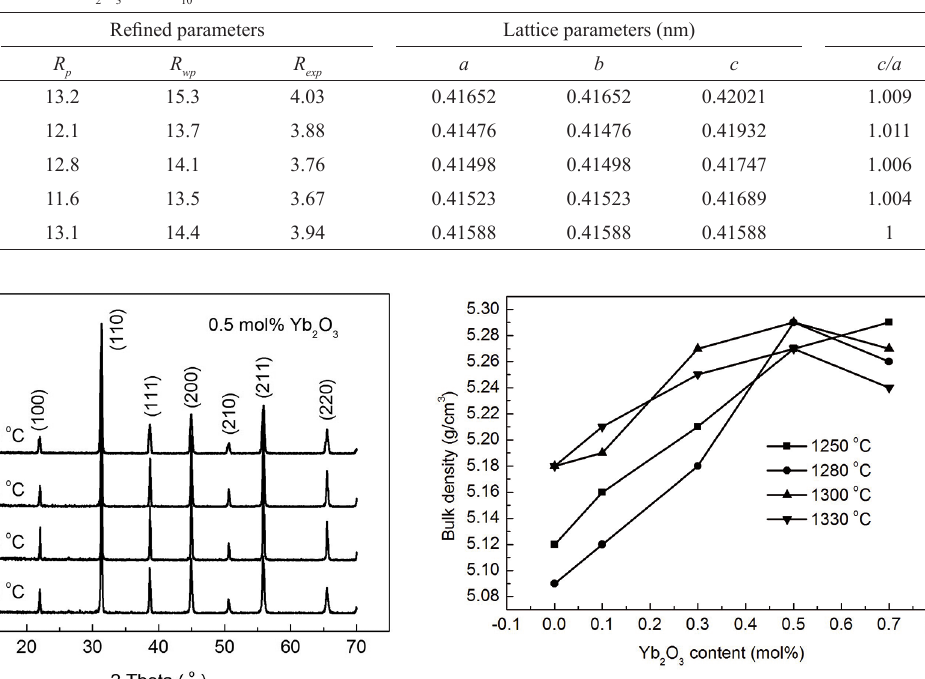
O ceramics sintered at 2 3